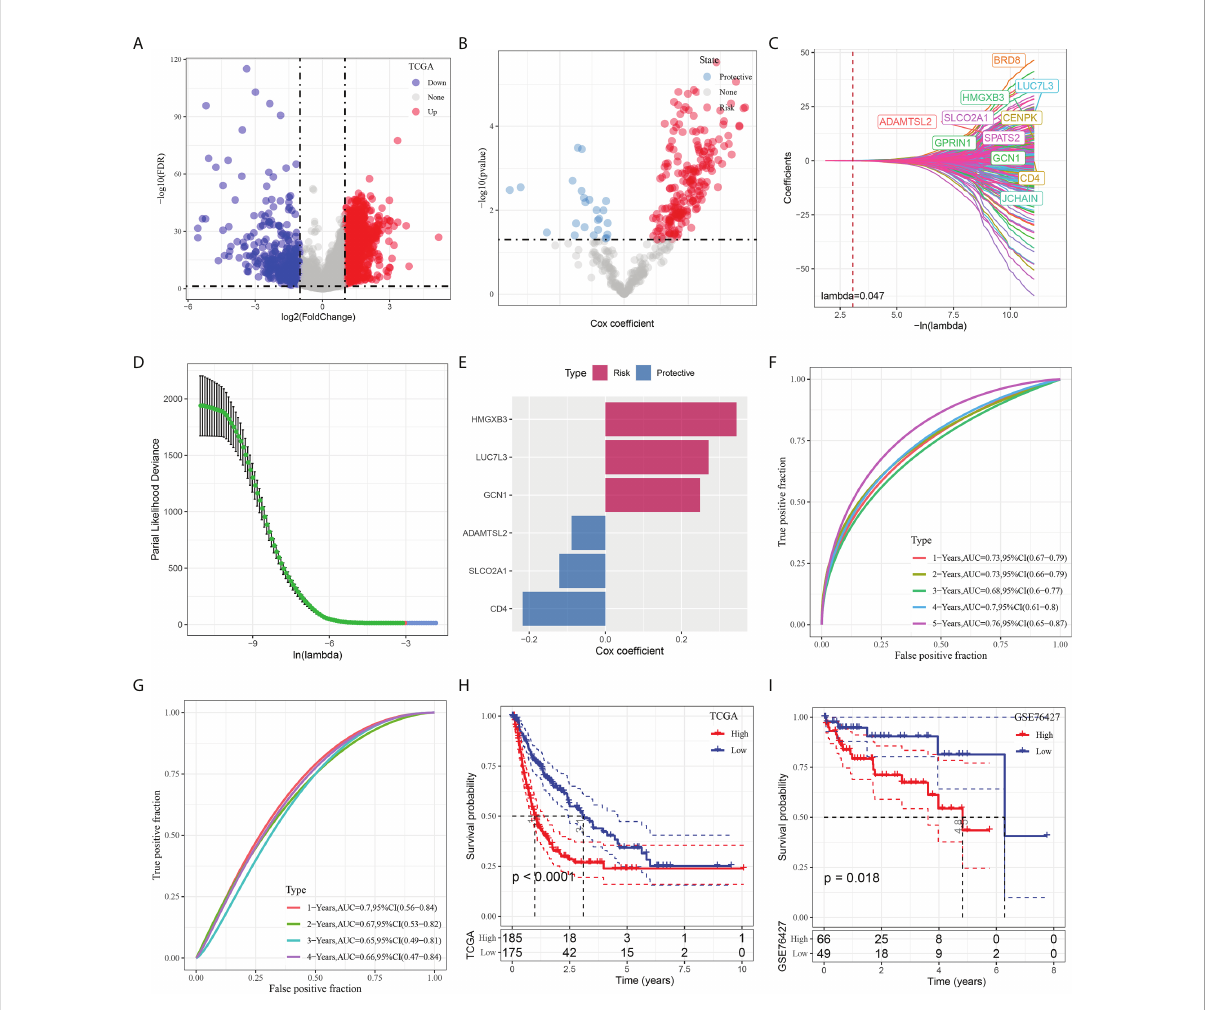
FIGURE 5 Identi fi cation of the hub predictive genes to construct a risk signature. (A) Volcano plot of differentially expressed genes of cancer and normal tissues in TCGA cohort; (B) Volcano plot of prognosis-related genes identi fi ed from univariate Cox regression analysis; (C) The trajectory of each independent variable with lambda; (D) Plots of the produced coef fi cient distributions for the logarithmic (lambda) series for parameter selection (lambda); (E) The multivariate Cox coef fi cients for each genes in the risk signature. (F) and (G) ROC curves of risk model constructed by 6 genes in TCGA cohort and GEO cohort; (H) and (I) K-M curves of risk model constructed by 6 genes in TCGA cohort and GEO